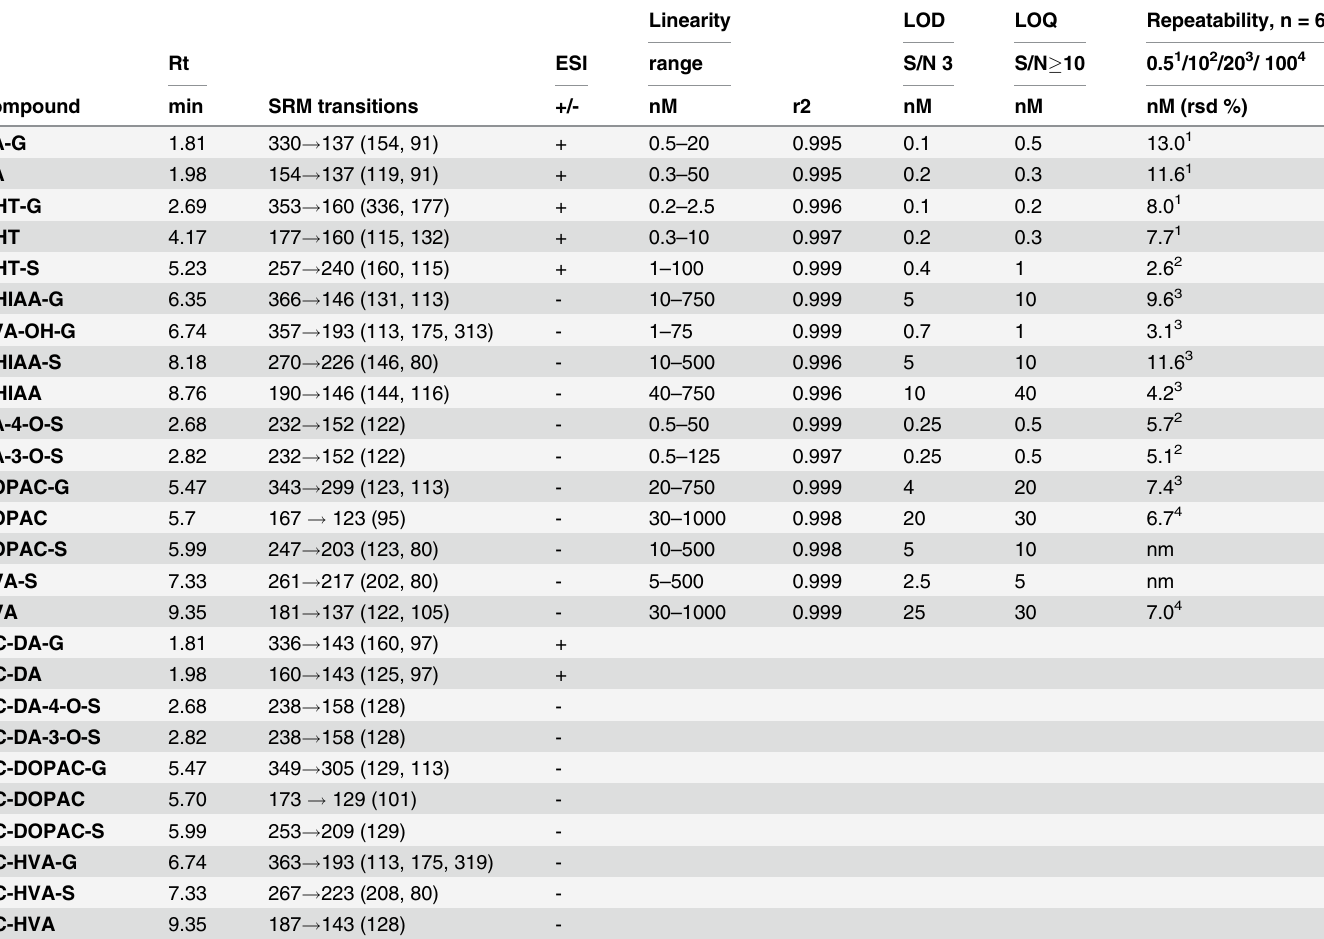
Table 1. The analytes, SRM transitions and validation